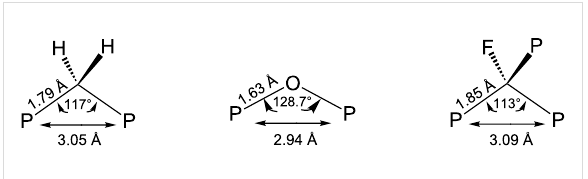
Structural features of the trisphosphonate 18 were studied by NMR spectroscopy and by single-crystal X-ray diffraction. Only one 31 P NMR signal is observable for three equivalent NMR spectrum of 18 revealed three separable signals. The and supported by crystallographic analysis. The molecules 18 bonded via hydrogen bonds form chains